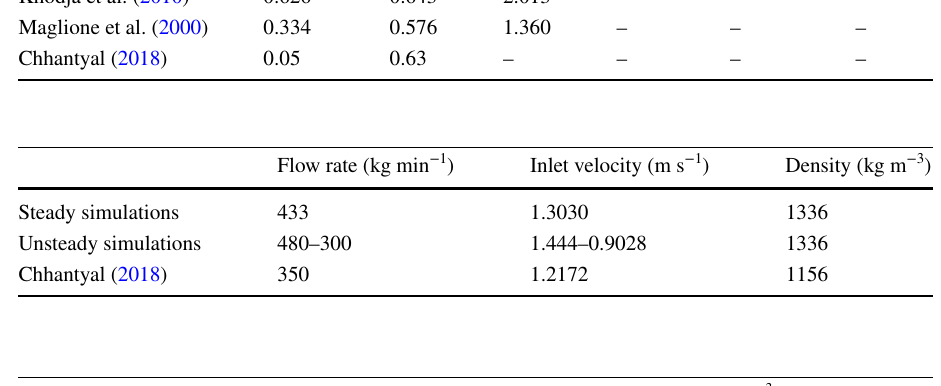
Herschel–Bulkley fluid rheological parameters and flow